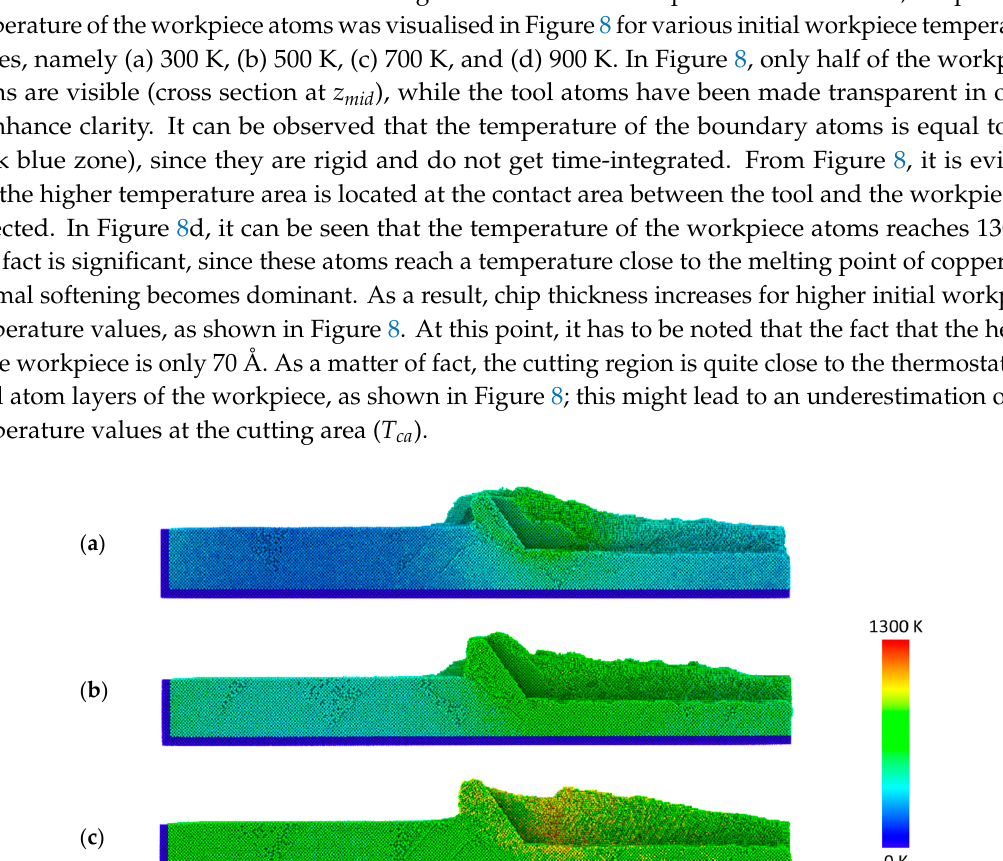
Figure 7. Average temperature at the cutting area ( T ca,ave ) vs. workpiece temperature ( T w ).